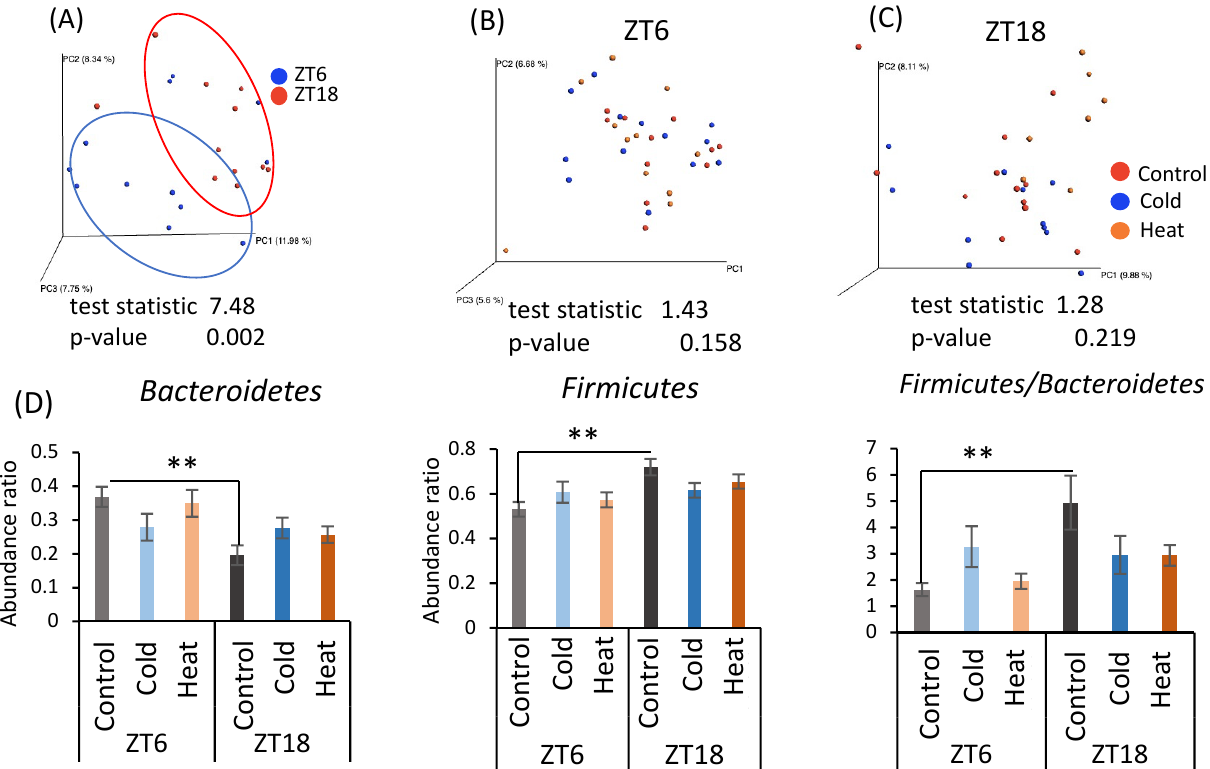
Figure 4. Effects of cold or heat exposure on β -diversity and the relative abundance of microbes at the phylum level. ( A ) β -diversity in comparison of ZT6 and ZT18 in the control group; ( B ) β -diversity in comparison of the control, cold, and heat groups at ZT6; ( C ) β -diversity in comparison of the control, cold, and heat groups at ZT18; ( D ) the relative abundance of microbes at the phylum level in mice were exposed to 22 or 7 or 37 °C for 3 h at each point (ZT6, 18) for 10 days. Data are represented as mean ± SEM ( n = 7–12). ** p < 0.01 evaluated using two-way ANOVA with Sidak’s post hoc